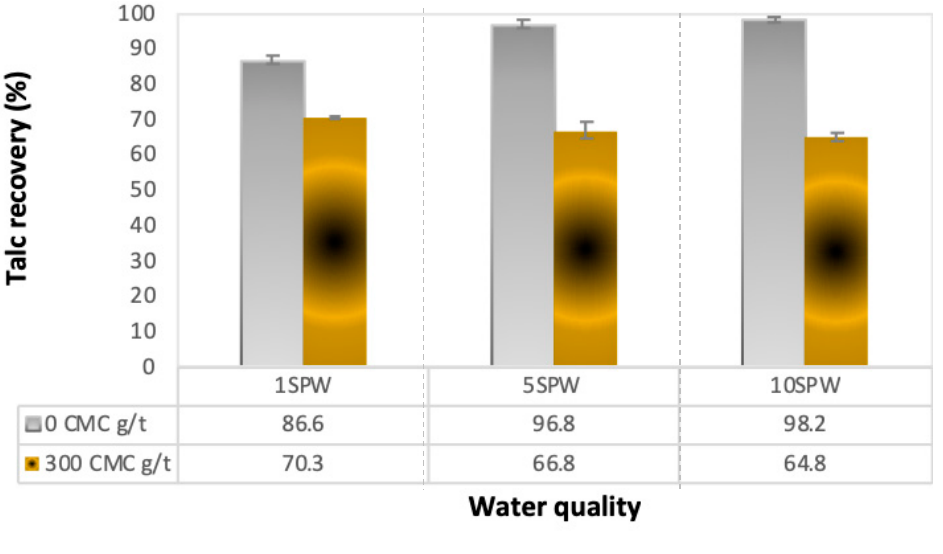
Figure 2. Total talc recoveries in increasing ionic strength without (0 CMC g/t) and with carboxymethyl cellulose (CMC) (300 CMC g/t).